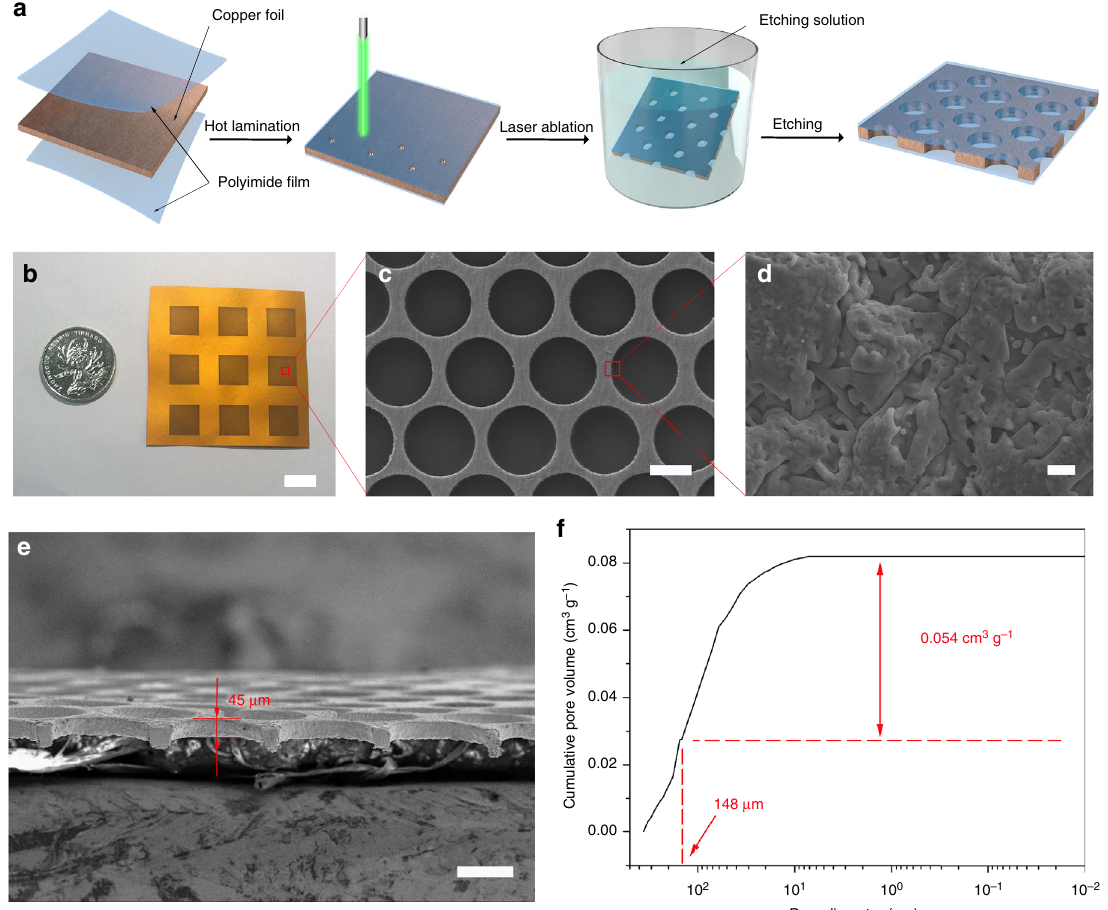
Fig. 1 Preparation and characterization of E-Cu. a Schematic of the fabrication process of E-Cu. b Photograph of the as-obtained E-Cu current collector. c Typical SEM overview image of E-Cu after peeling off the coated PI fi lms. d Magni fi ed SEM image of the edge of the copper scaffold from c . Scale bars in b – d are 1 cm, 100 μ m and 1 μ m, respectively. e Typical cross-sectional SEM image of E-Cu after peeling off the surface PI fi lms. Scale bar in e is 100 μ m. f Cumulative pore volume of E-Cu by mercury porosimetry. Herein, the diameter of interior compartments is controlled to be ~150 μ m, which was in accordance to the porosity analysis result (148 μ m), as marked in red colour in f . The weight of E-Cu tested here was 0.3141 g and the total surface area for all the compartments was 9 cm 2 ; thus, the effective pore volume of E-Cu is 1.88 × 10 − 3 cm 3 cm −